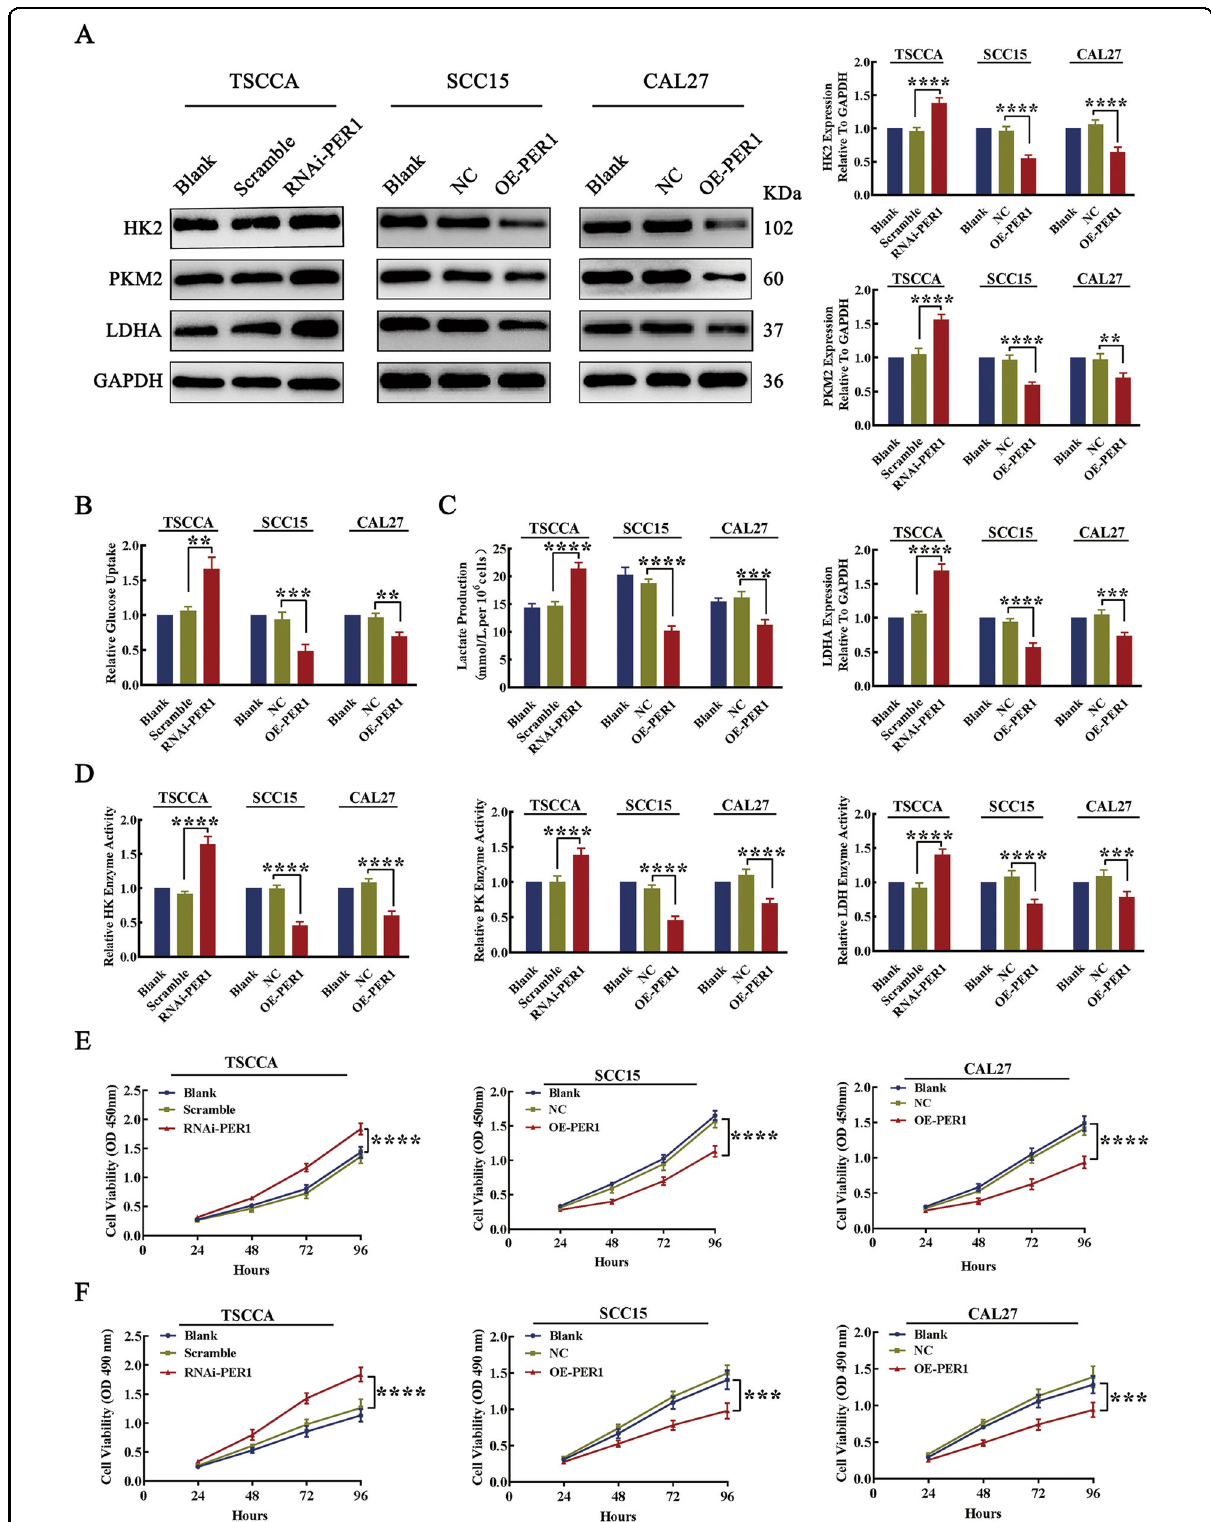
Fig. 2 (See legend on next